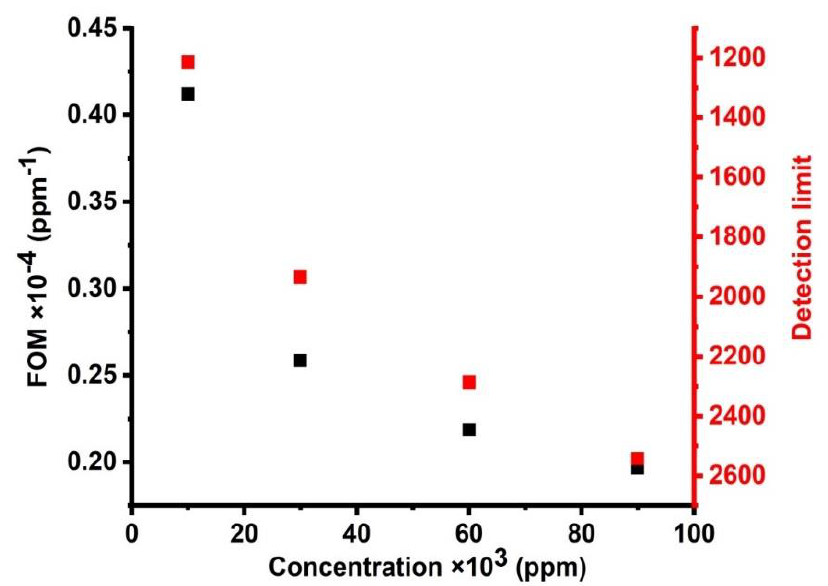
Figure 12. The effect of different concentrations on the figure of merit and detection limit of cadmium bromide liquid sensor.